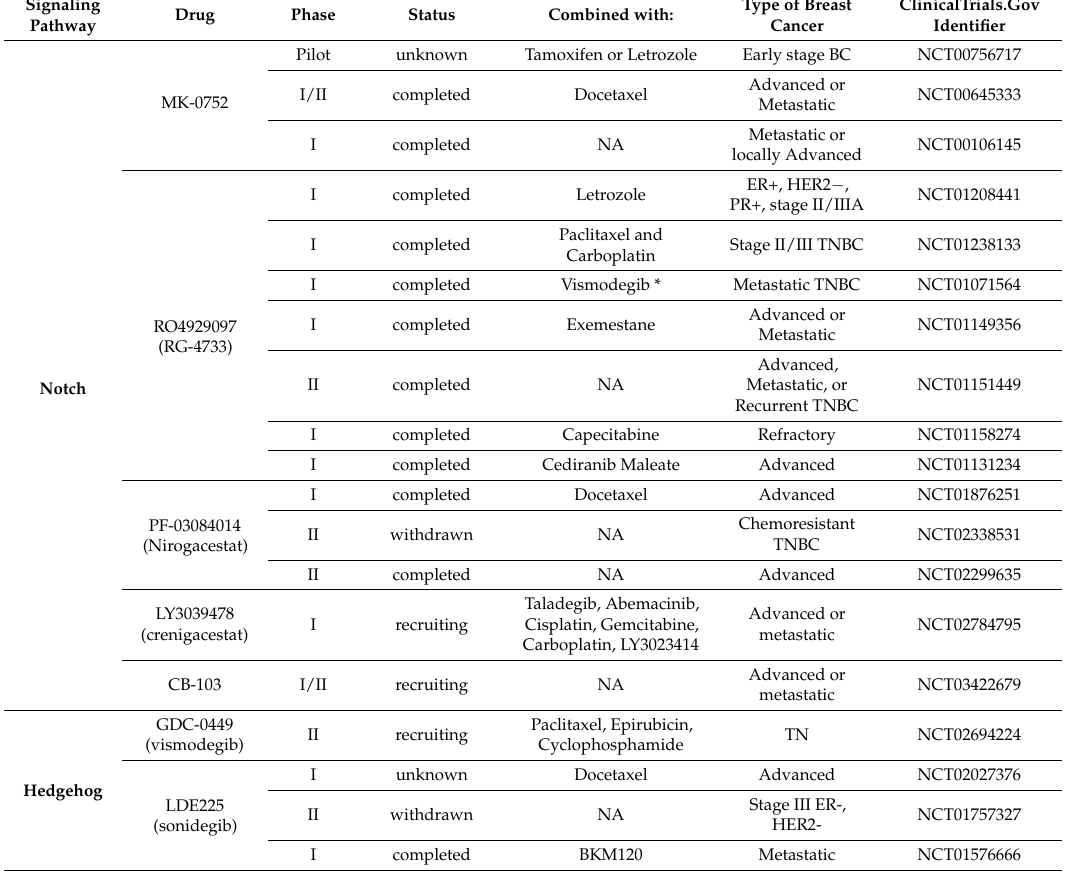
Table 1. Inhibitors of BCSCs signaling pathways in clinical